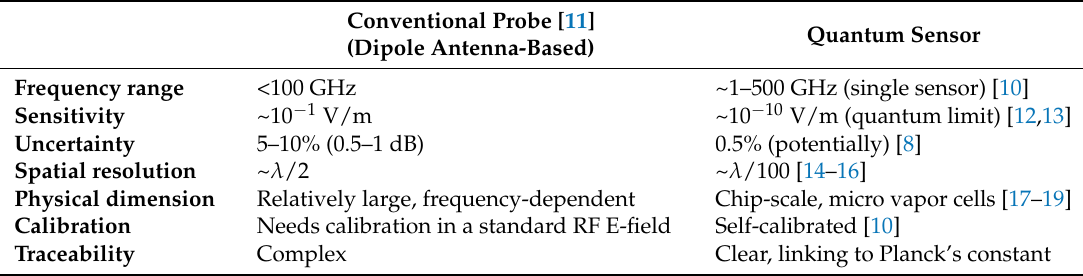
Table 1. Comparison of radio-frequency (RF) electric field (E-field)